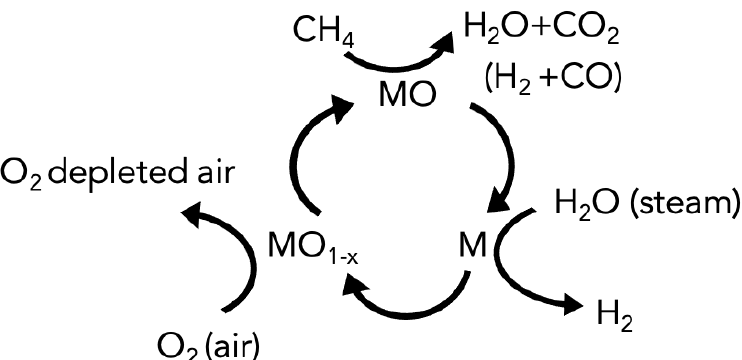
Figure 5. Example of chemical looping-based process for the production of H 2 from CH 4 , using metal oxide as catalyst. See the main text and [44,45] for details.